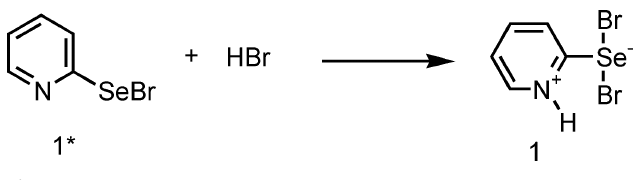
Figure 3 The addition reaction of hydrogen bromide to selenenyl bromide 1* .